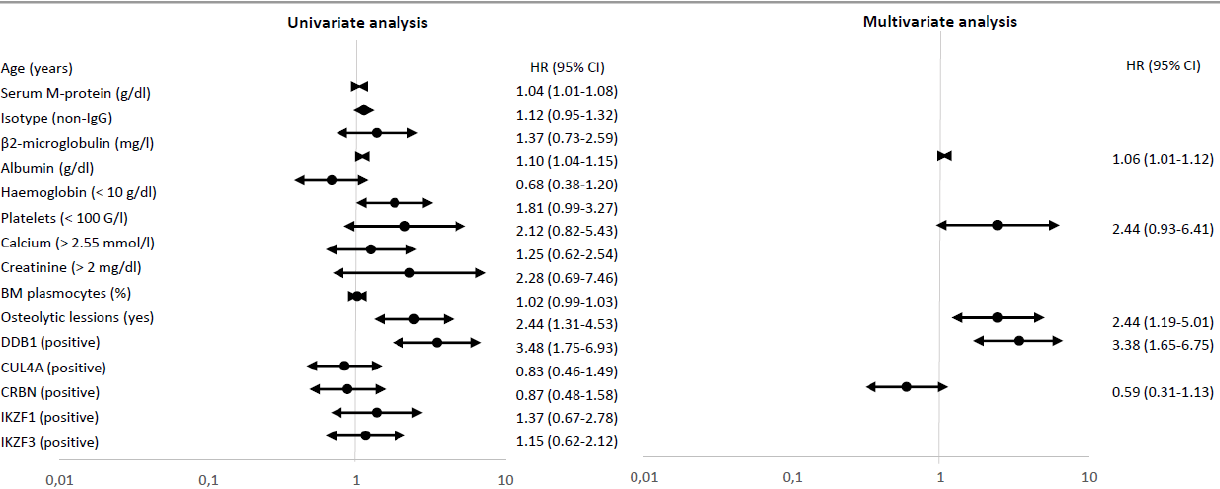
Figure 2. Univariate and multivariate Cox regression analyses for OS ( n = 97). If the hazard ratio (HR) is greater than 1, then the predictor is associated with an increased risk of death.